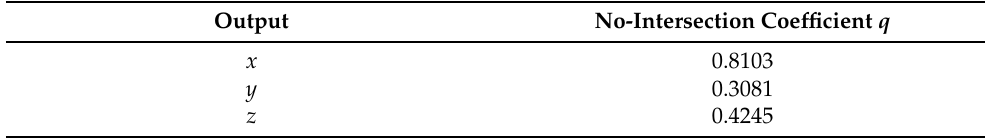
Table 1. The value for the intersection coefficient in the context of Lorenz